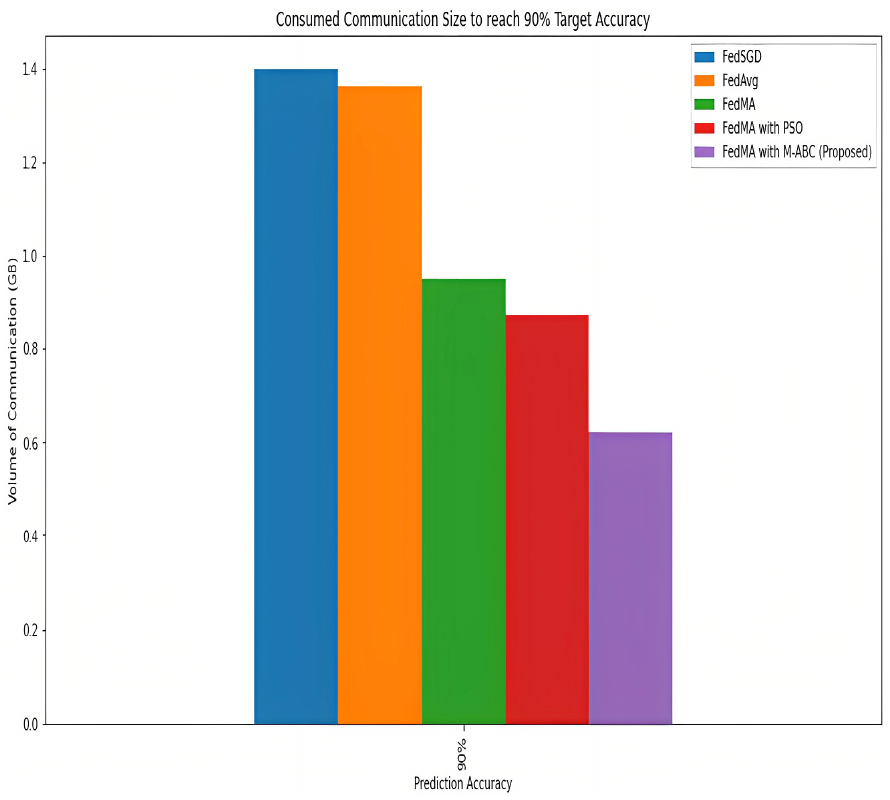
Figure 5. Comparison of communication size consumed to reach 90% prediction accuracy.